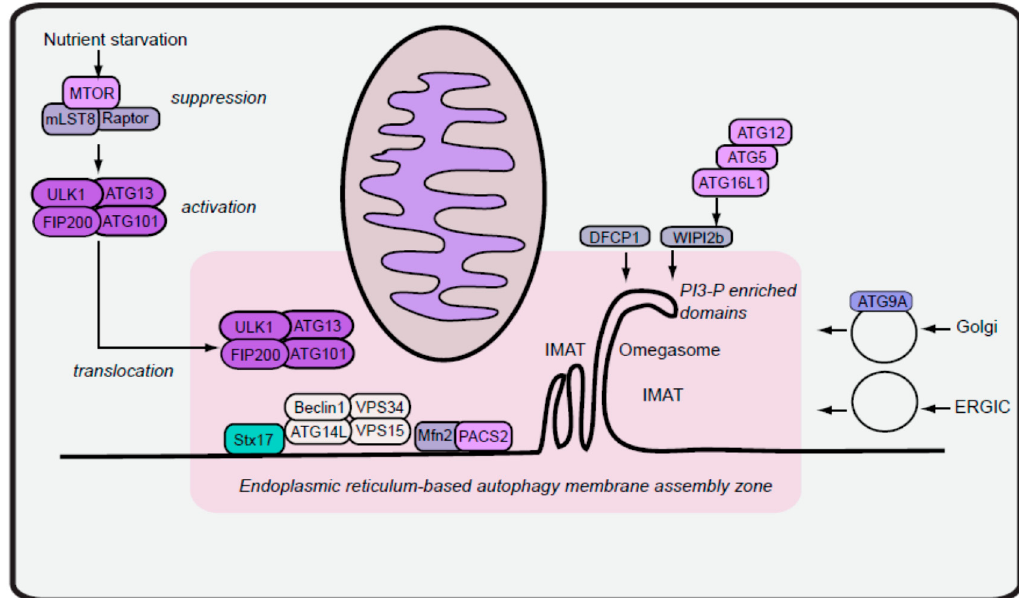
Figure 1. Assembly of autophagy isolation membranes . Starvation of nutrients leads to suppression of MTOR complex 1 resulting in downstream activation of the ULK1 autophagy initiation complex. The activated ULK1 complex translocates to an ER-based early autophagy membrane assembly zone associated with mitochondria contact sites, maintained in part via mitofusin 2 (Mfn2) and phosphofurin acidic cluster sorting protein-2 (PACS2). This assembly zone corresponds to early autophagy initiation puncta visualised by light microscopy. Activated ULK1 signals downstream by phosphorylating and activating the Beclin 1–VPS34–ATG14L–VPS15 complex, driving the generation of isolation membrane associated tubules (IMAT) and the omegasome. PI3P-enriched microdomains recruit markers like DFCP1 and machinery like WIPI2b along with further associated factors such as the ATG16L1–ATG5–ATG12 complex. After initial stages of membrane assembly, Golgi-derived vesicles containing ATG9A- and ERGIC-derived vesicles contribute further membranes and assembly machinery.